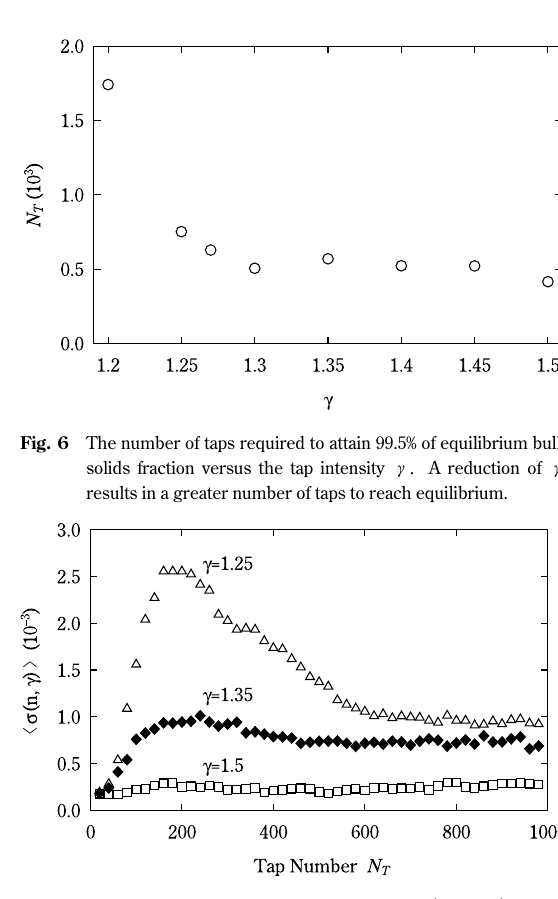
Fig. 7 The standard deviation of bulk solids fraction 〈σ (n; γ ) 〉 versus tap number N T for tap intensity γ＝ 1.25 ( Δ ), 1.35 ( ♢ ) and 1.50 ( * ). Smaller values of γ yield higher variances.